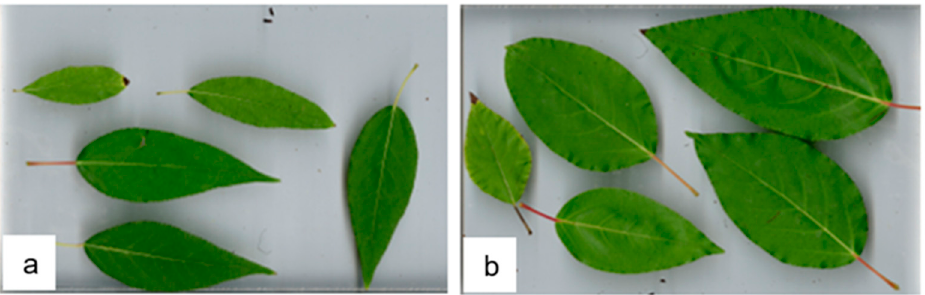
Figure 2. Morphological differences between leaves of different poplar clones ( a ) ‘AUCE’, ( b )